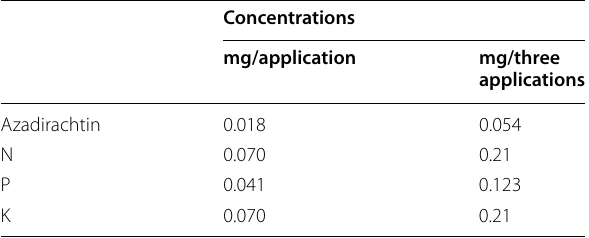
Table 5 Quantities of azadirachtin insecticide or/and NPK fertilizer poured in a foliar